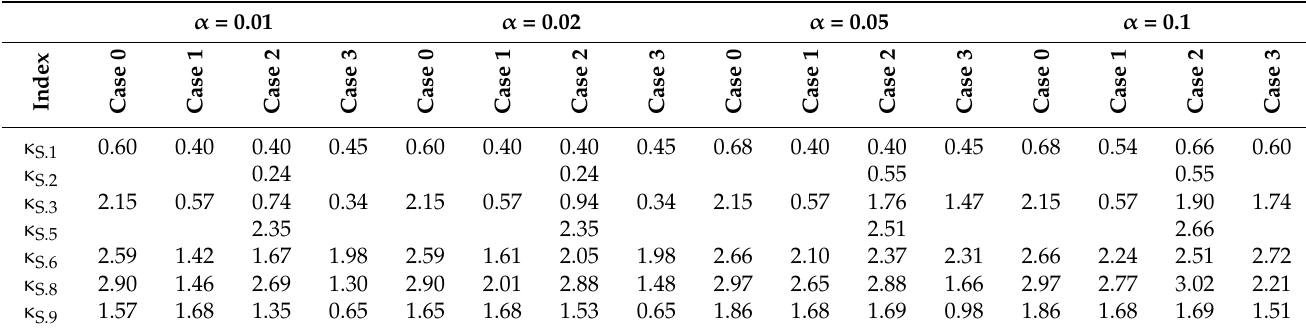
Table 25. Indices κ S, j Characterizing Influence Sets Associated with Dominant Nodal Reactive Powers in Case 0. Case 1. Case 2 and Case 3.